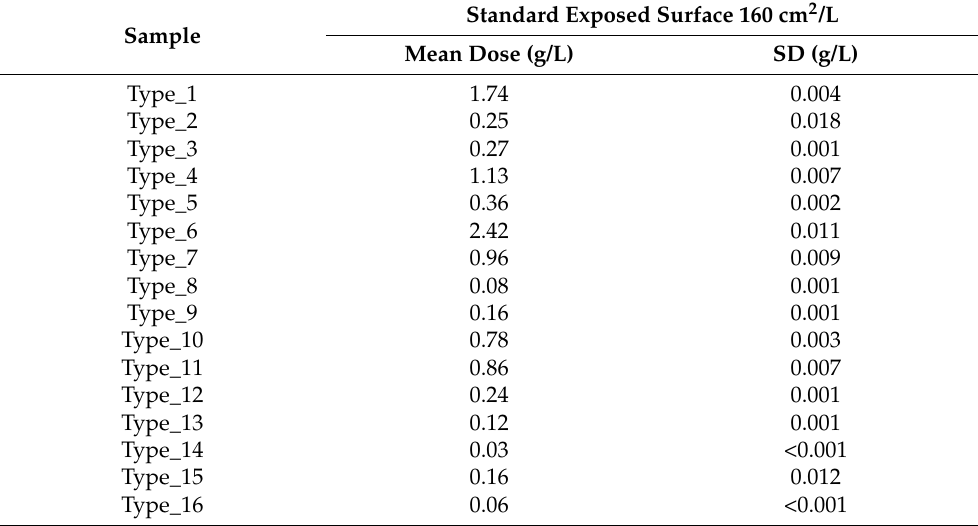
Table 2. Mean dose ( ± standard deviation; SD) of each packaging materials calculated from a standard exposure surface of 160 cm 2